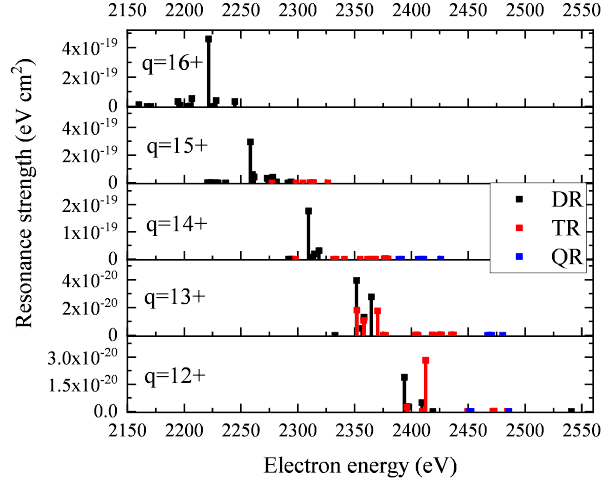
Figure 3. The results of the FAC calculation of the resonance strength of the DR K-LL (black), TR KL-LLL (red), and QR KLL-LLLL (blue) for ions Ar 16 + -Ar 12 + . The results are added within the E e = 1 eV window.